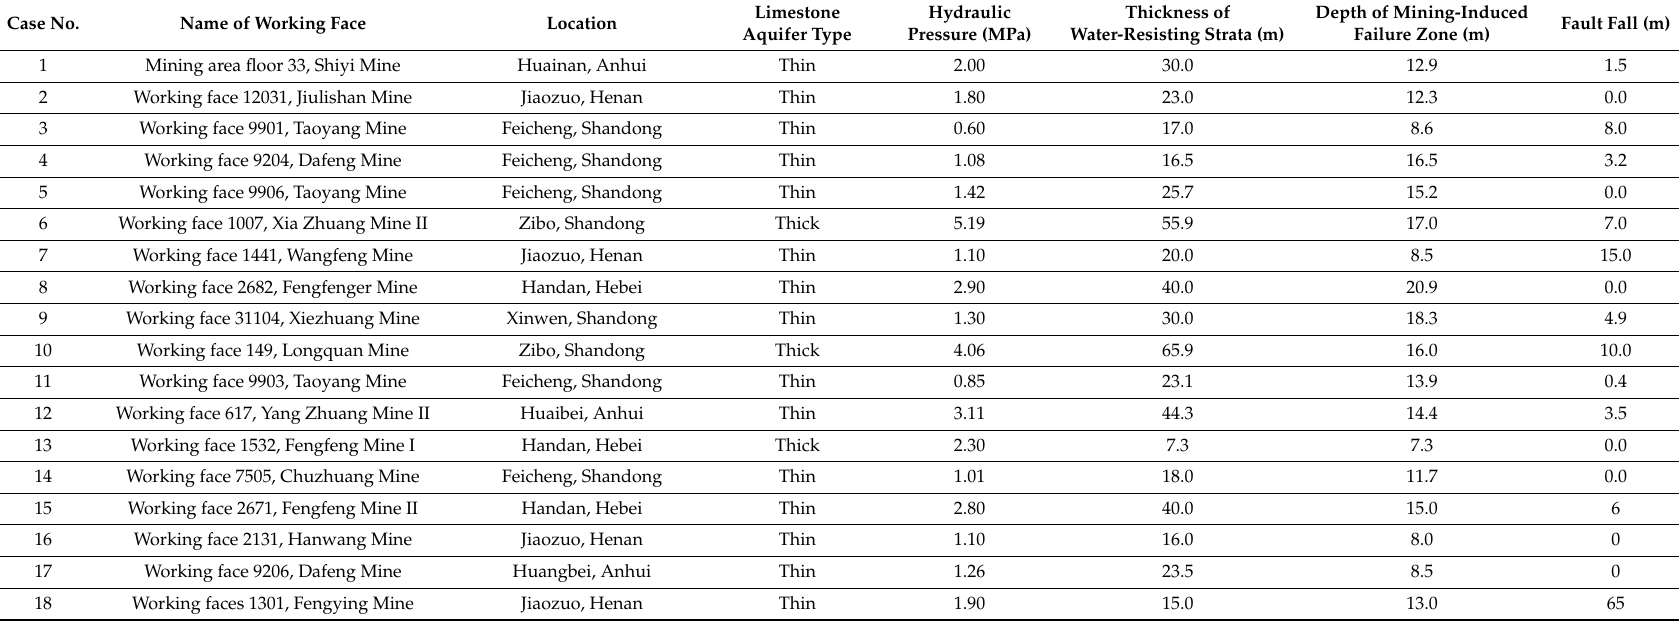
Table 1. Influencing factors of water inrush